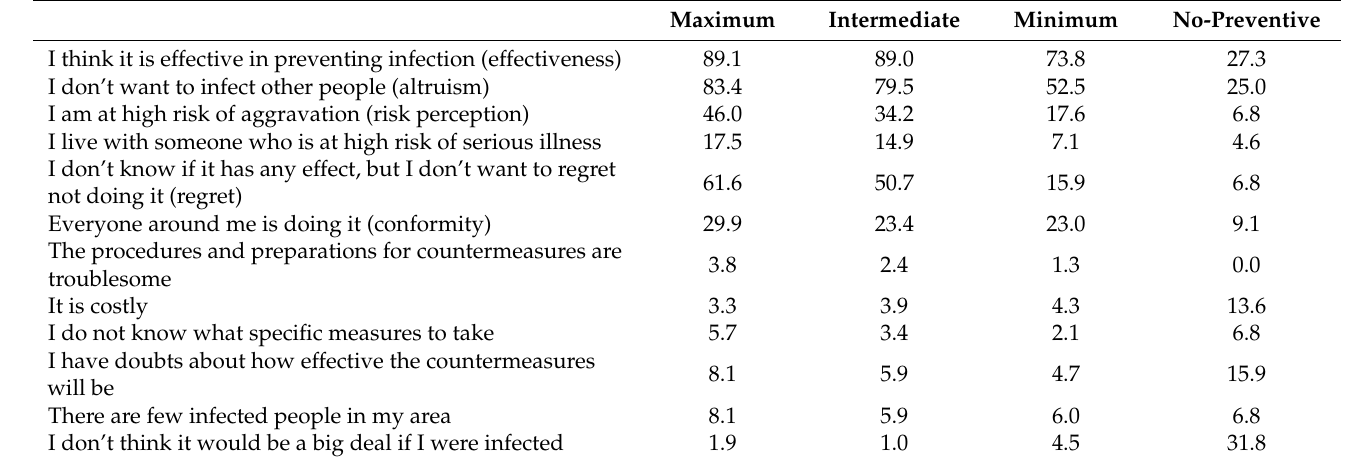
Table 7. Reasons for implementing/not implementing preventive